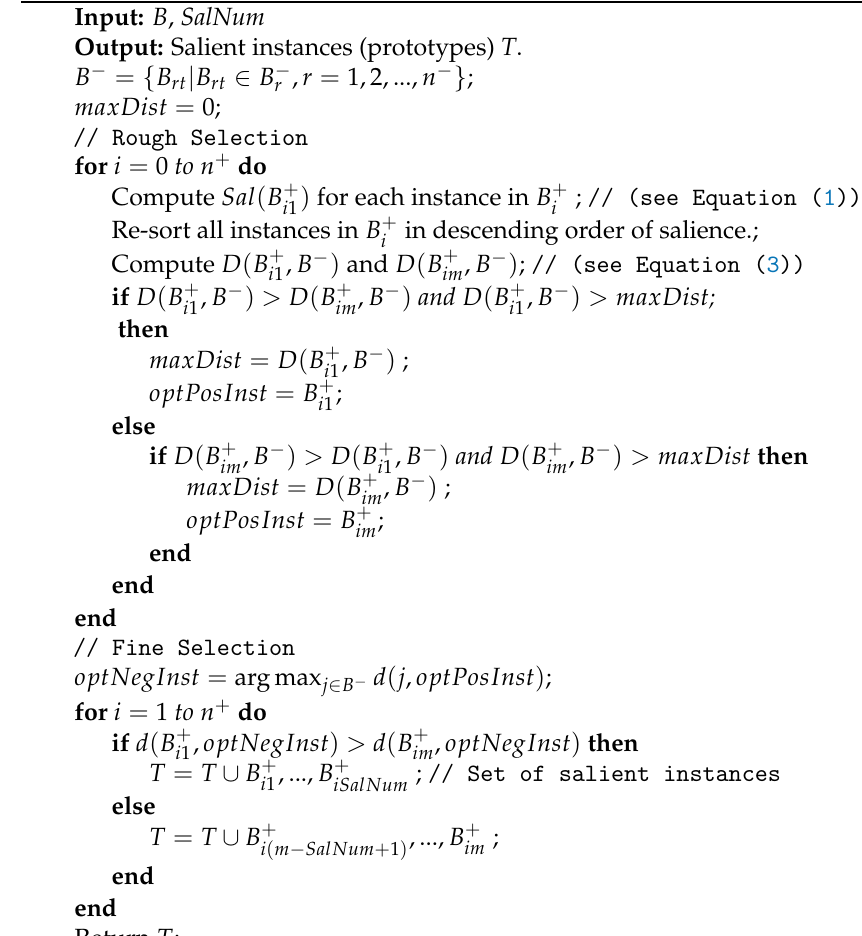
Algorithm 1: MILSIS: Salience Instance